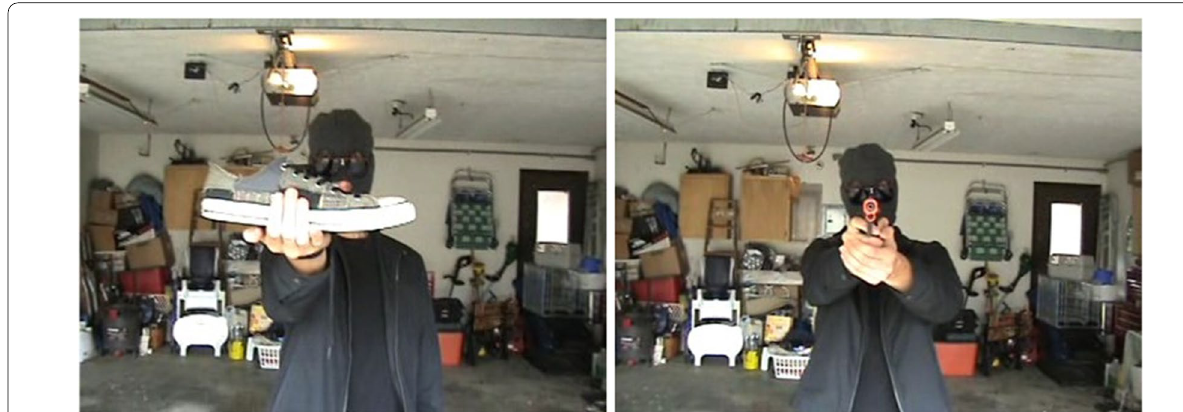
Fig. 1 Sample stimuli of the shoe (left) and gun (right) conditions